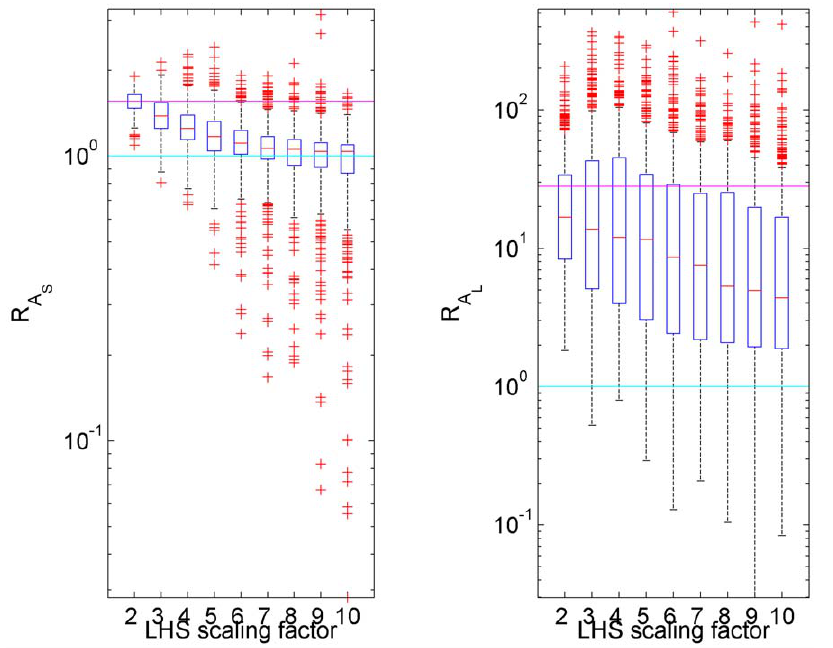
Figure 10. The peaks ratio for IgM and IgG of replicates with variable parameter values selected using LHS, for different multiples. Plots give the median (red bar), 25–75th percentile (box plot), non-outlier range (whiskers) and outliers (red cross) for each multiple set. In addition the ratio from the estimated parameter set is marked (magenta) together with the value 1 (cyan), where the ratio would switch from an increase to a decrease and which would represent a significant qualitative change in dynamics.